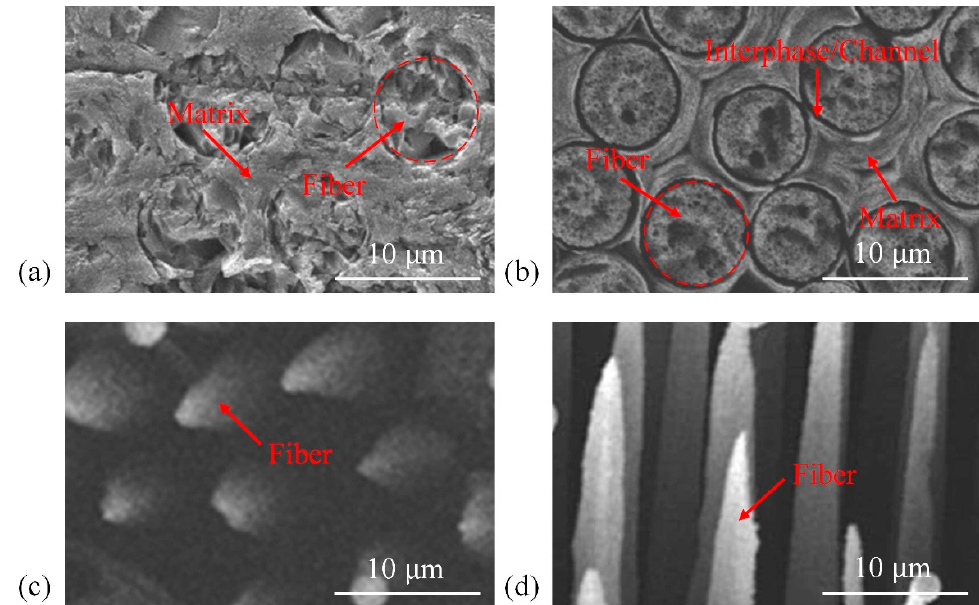
Figure 2. SEM images of C/C composites ( a ) before oxidation; ( b ) after oxidation at 1200 °C in air for 5 min; ( c , d ) after oxidation at 1200 °C in air for 15 min.